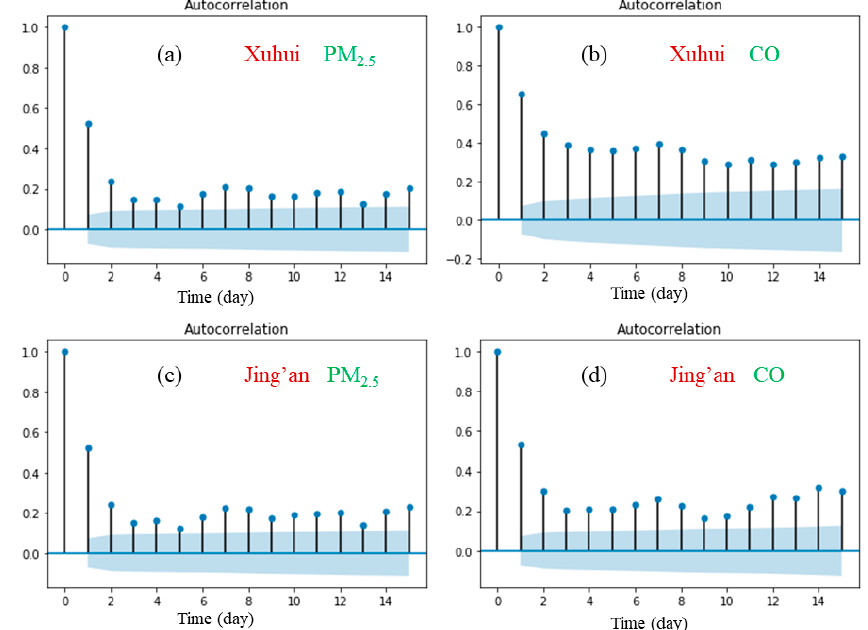
Figure 8. Autocorrelation function (with 95% confidence intervals) of daily air quality data in the two monitoring stations. ( a ) Xuhui, PM 2.5 ( b ) Xuhui, CO ( c ) Jing’an, PM 2.5 ( d ) Jing’an, CO.